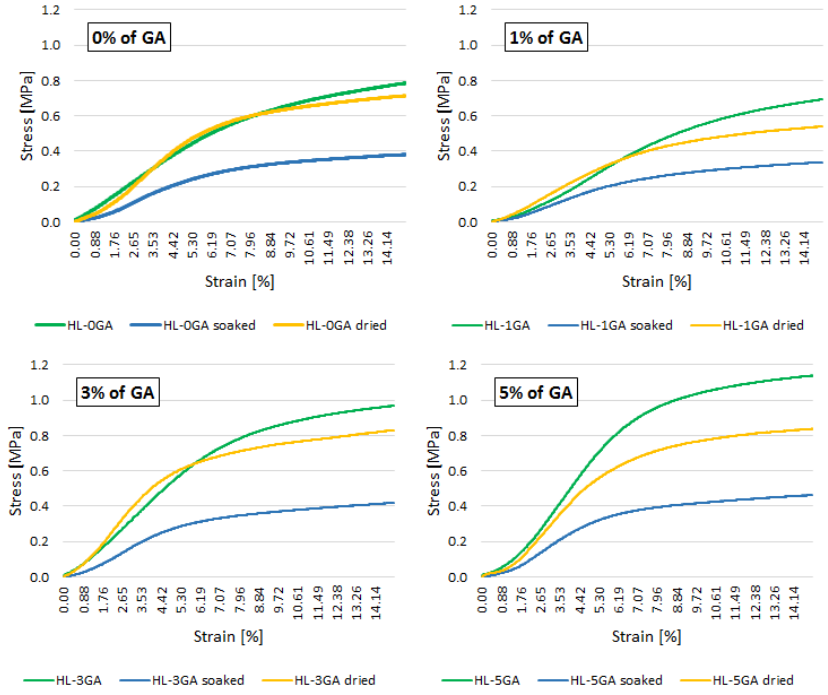
Figure 14. Stress–strain relationship of tested composites in various variants (average values). Figure 14. Stress – strain relationship of tested composites in various variants (average values). The results of Young’s modulus are presented in the diagram (Figure The results of Young ’ s modulus are presented in the diagram (Figure 15).